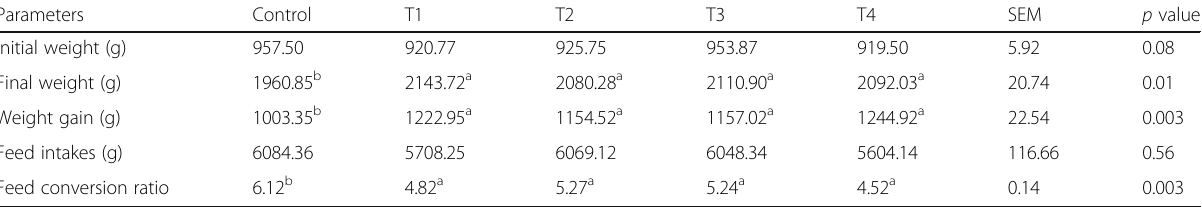
Table 2 Effect of Chlorella vulgaris supplementation on performances of the rabbits Parameters